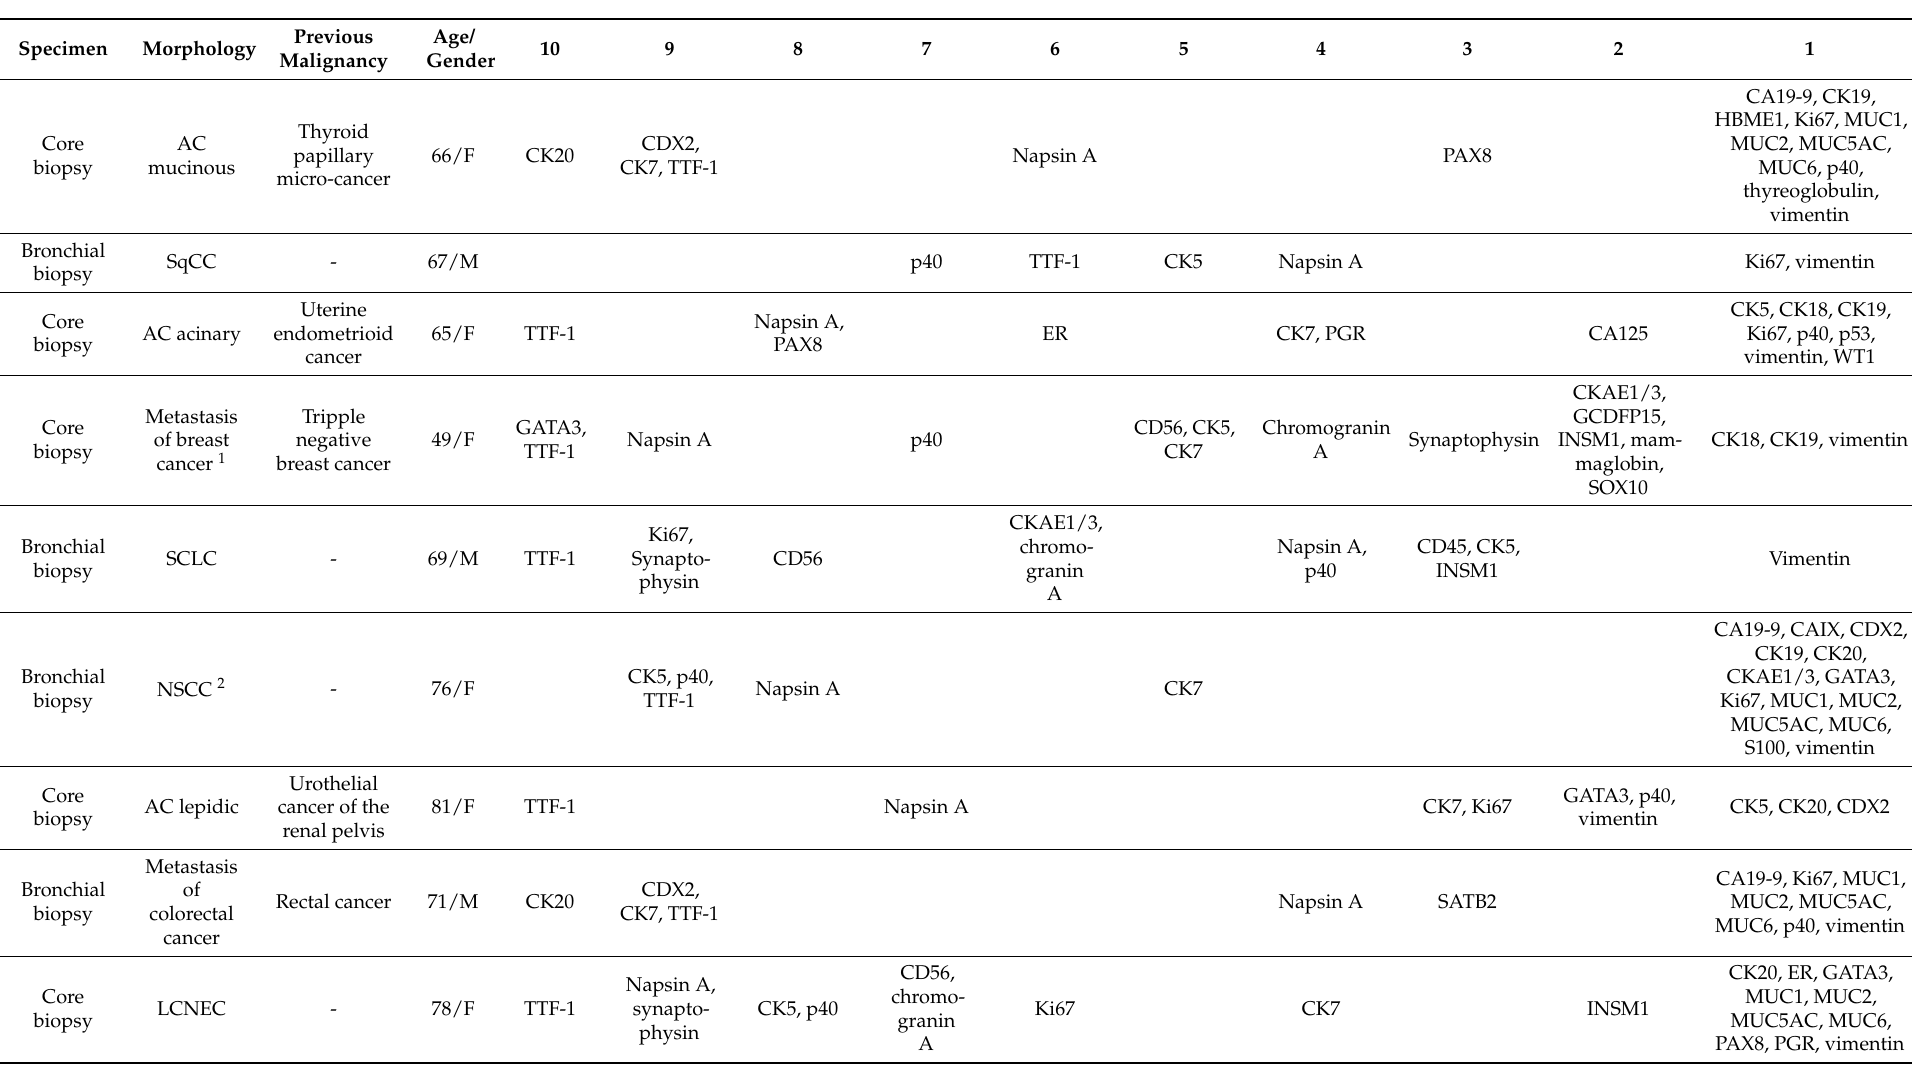
Table 4. The number of participating pathologists suggesting various immunohistochemical markers for the differential diagnosis of 15 cases of pulmonary tumors.